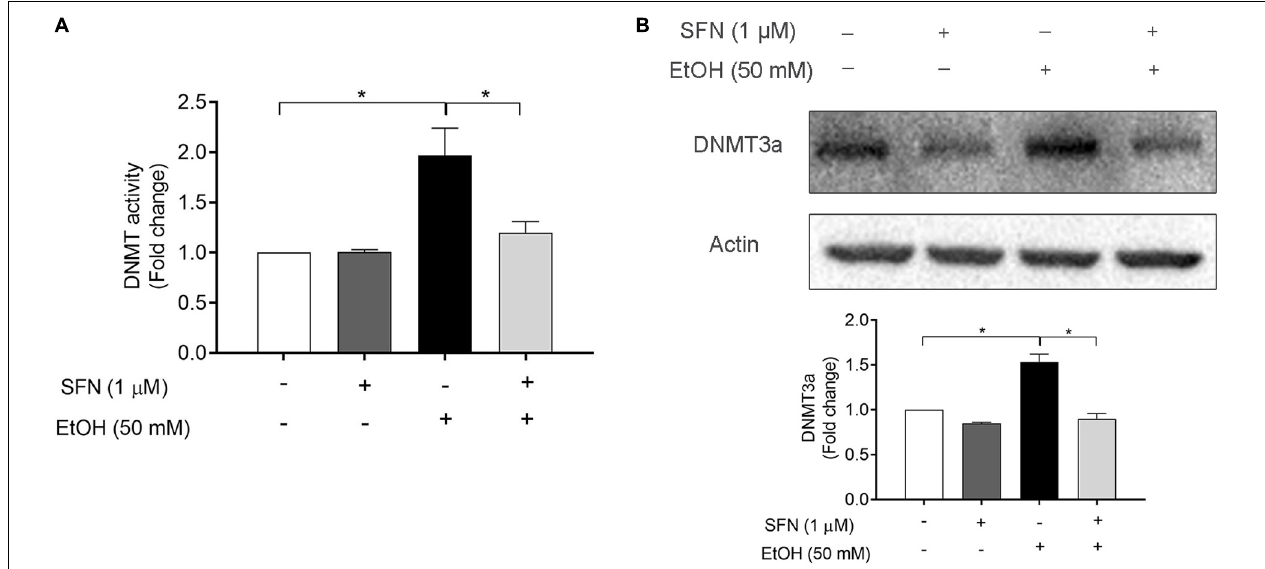
FIGURE 2 | SFN diminished ethanol-induced increase in DNMT activity and the up-regulation of DNMT3a in hNCCs. hNCCs were treated with 1 µ M SFN for 24 h, followed by concurrent exposure to 1 µ M SFN and 50 mM ethanol for an additional 24 h. (A) The DNMT activity was determined by using an EpiQuik DNA Methyltransferase Activity Assay kit. (B) The protein expression of DNMT3a was determined by Western blotting. Data are expressed as fold change over control and represent the mean ± SEM of three separated experiments. * p < 0.05.